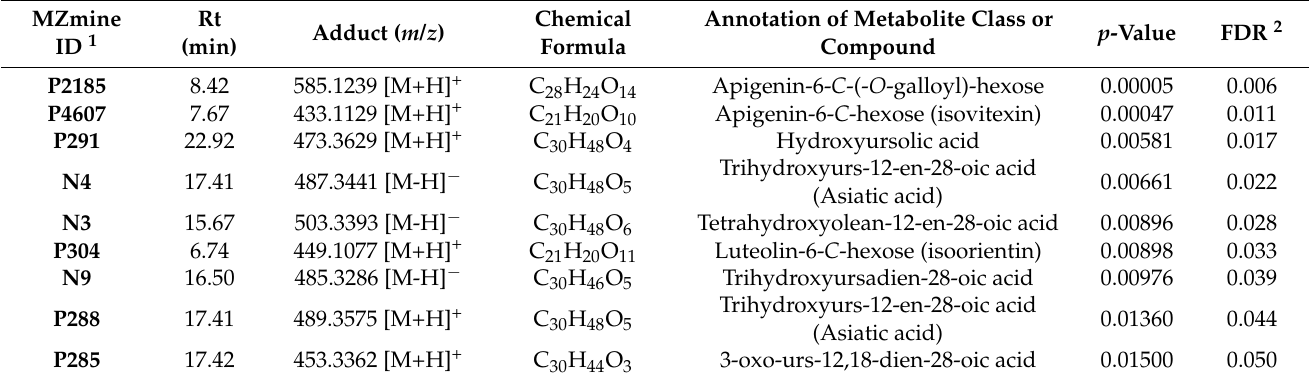
Table 2. Discriminant features for the MS data that contribute to the differentiation of the seasonal harvests of T. catappa